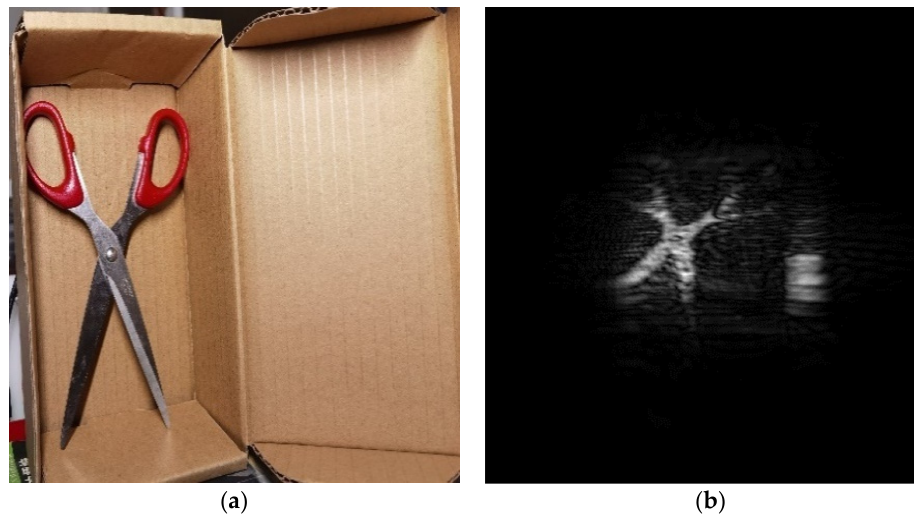
Figure 7. ( a ) The actual picture of scissors covered by paper box; ( b ) SAR image of scissors covered by paper box 90 mm from radar.